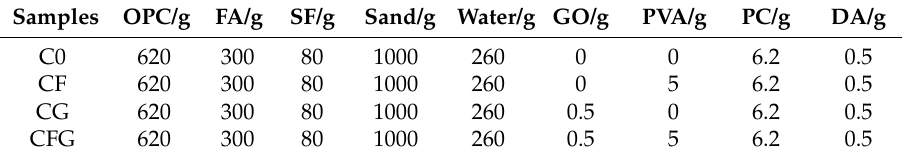
Table 2. Mix proportion of cement-based materials. C0 represents the control sample, CF and CG represent the polyvinyl alcohol (PVA) fiber and GO modified sample, respectively. CFG represents the GO coupling with the PVA fiber modified sample. PC = polycarboxylate; DA = defoaming agents. Samples OPC/g